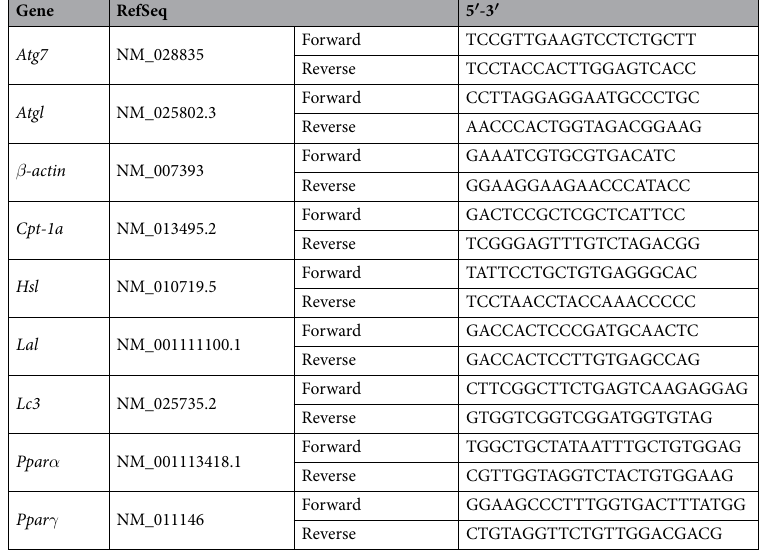
Table 2. Primer used for real-time PCR